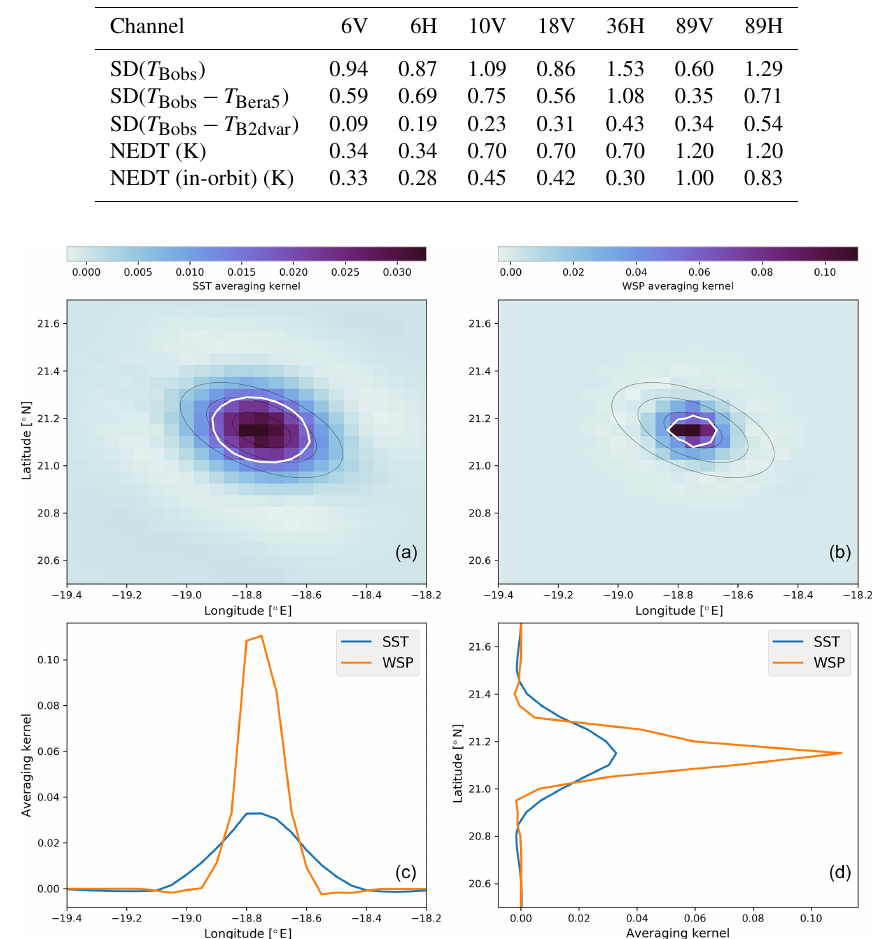
Figure 9. Averaging kernels from near the middle of the retrieval grid for the tropical Atlantic case. Panels (a) and (b) show the 2-D averaging kernels for SST and WSP for one point on the retrieval grid. Overlaid are outlines of the HPBWs of 6, 10, and 18GHz channels in black, along with a contour of the half-power of the averaging kernel in white. Panels (c, d) show longitudinal and latitudinal transects through the centres of the plots